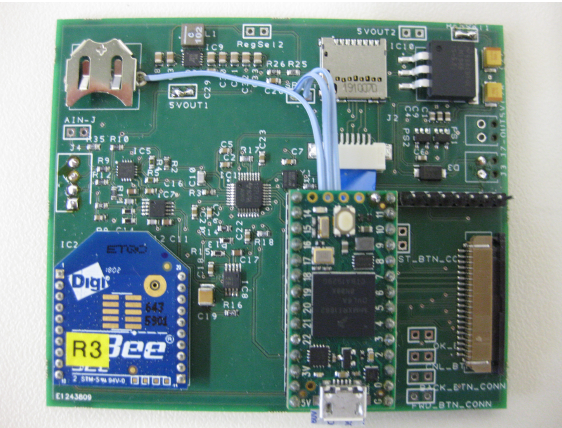
Figure 3. The main printed circuit board including the core elements of the HiFUSPEx prototype. Overall dimensions of the board: 85.2 mm × 72.5